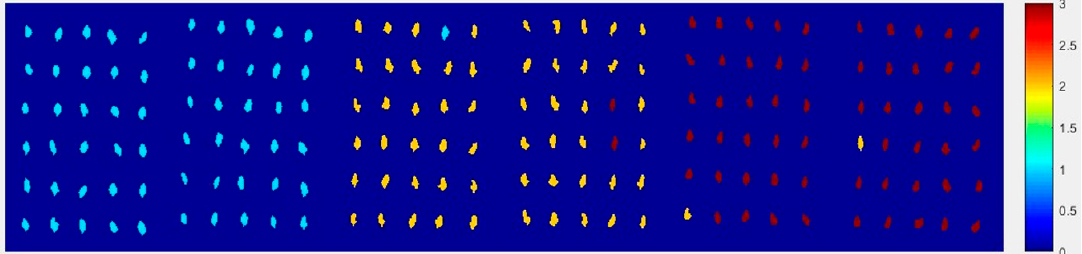
Table 3. The percentage of the two categories of Haihe78 corn seed samples.